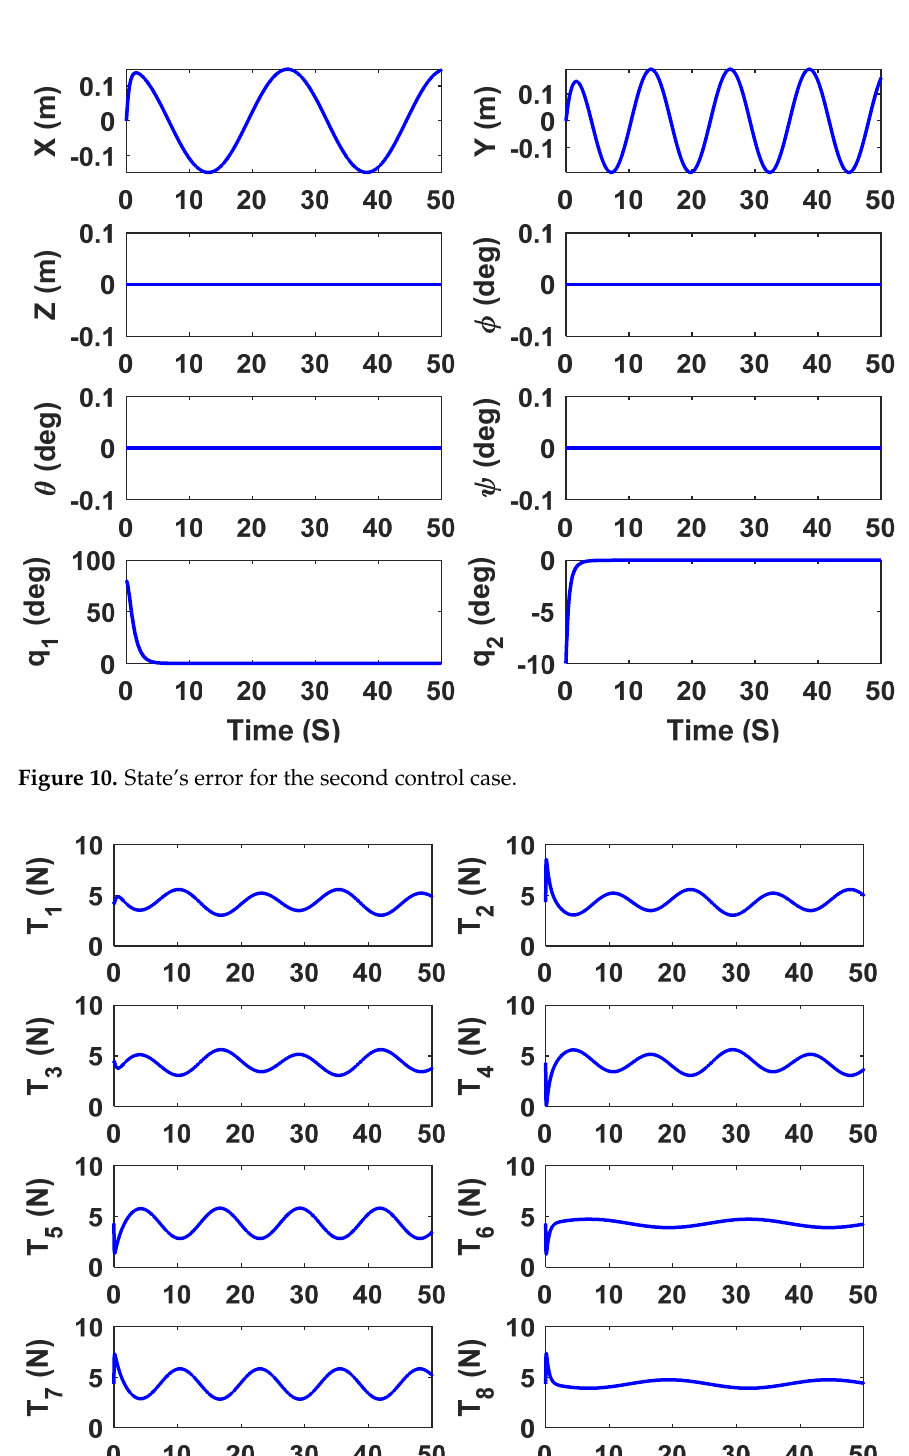
Figure 9. States of ACMS for the second control case (reference: red).